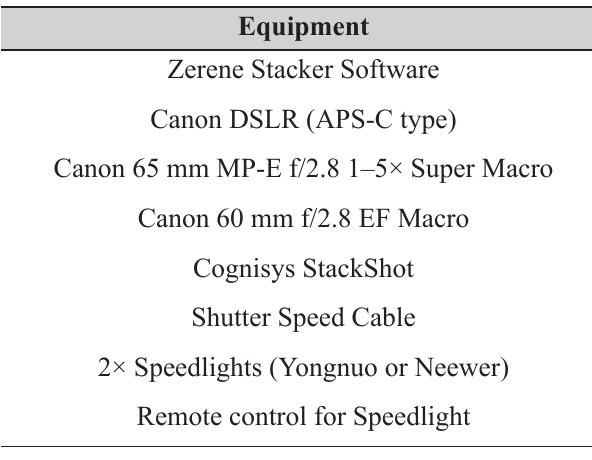
Table 2.1. Equipment used for the 2D+ DSLR Setup at RBINS and